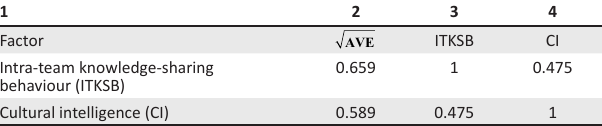
TABLE 4: Average variance extracted values versus correlation estimates.